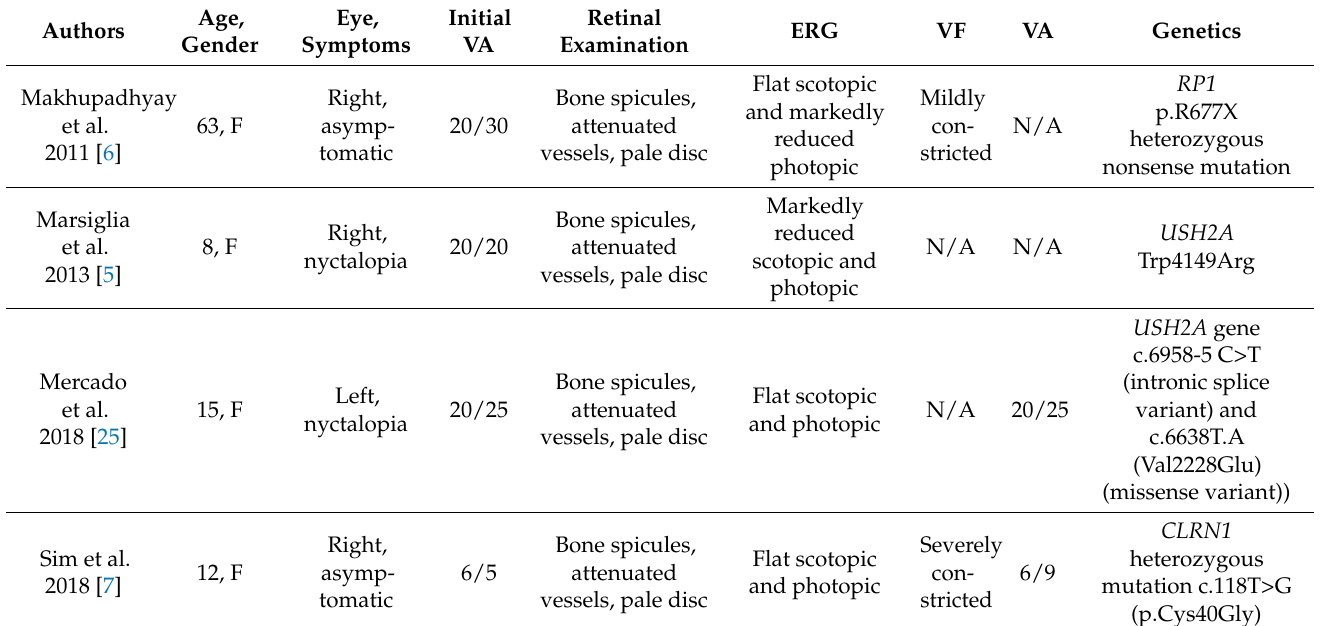
Table 3. Unilateral RP cases in the literature confirmed by genetic